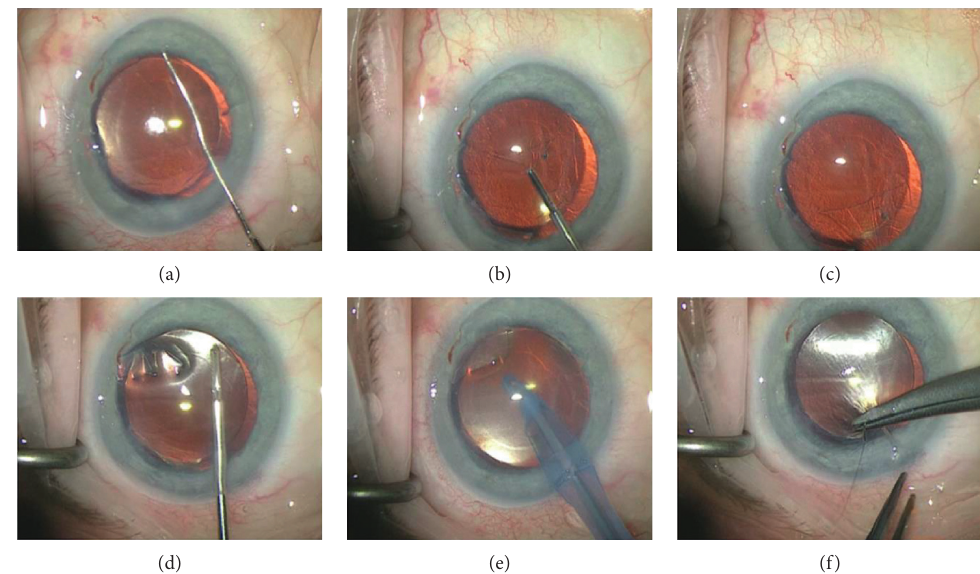
Figure 3: Descemetorhexis: (a) starting point; (b, c) peeling of the recipient Descemet’s membrane and endothelium; (d) remnants removal; (e) AC washout; (f)